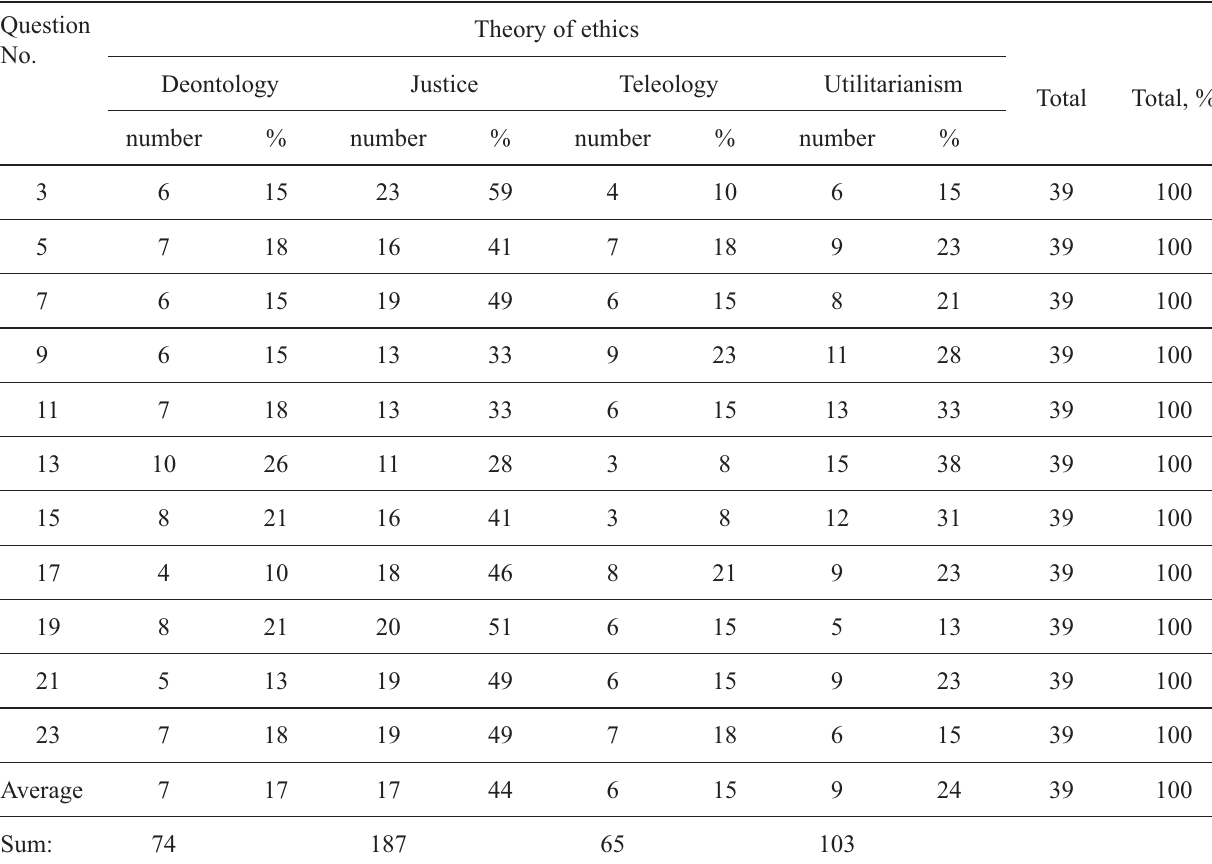
Table 3. Theories of ethics selected by the